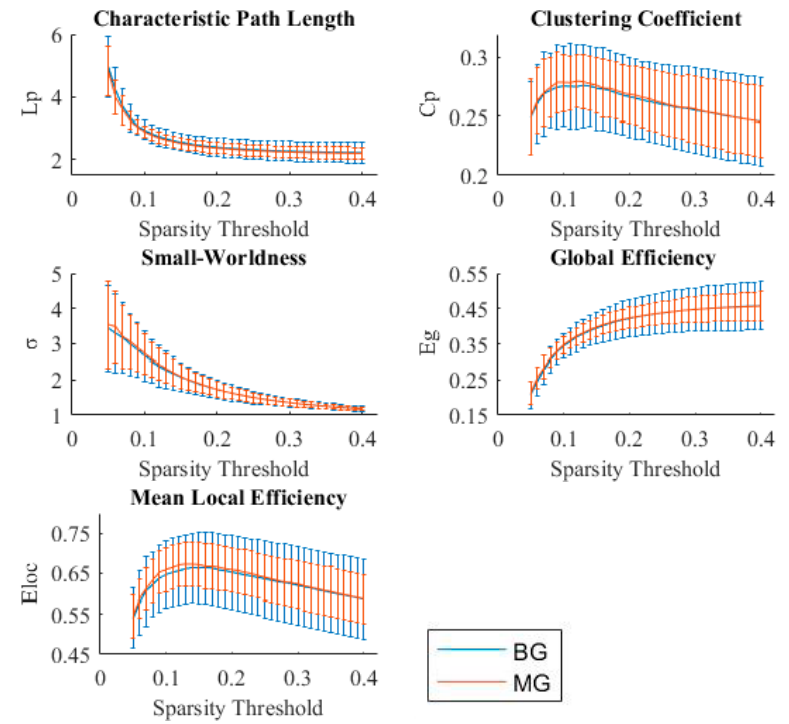
Figure 3. Comparison of global network metrics between Cantonese-Mandarin bilinguals and Mandarin monolinguals (BG = Cantonese-Mandarin bilinguals, and MG = Mandarin monolinguals).